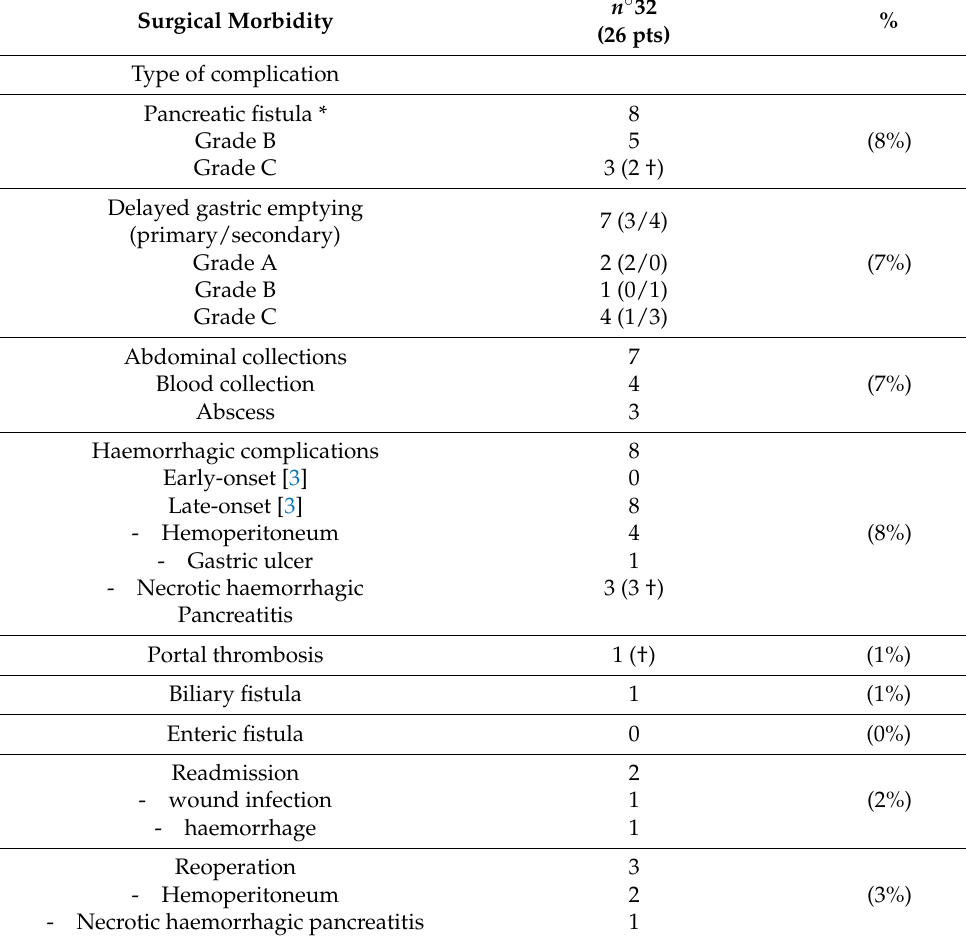
Table 4. Surgical Morbidity: 32 complications occurred in 26